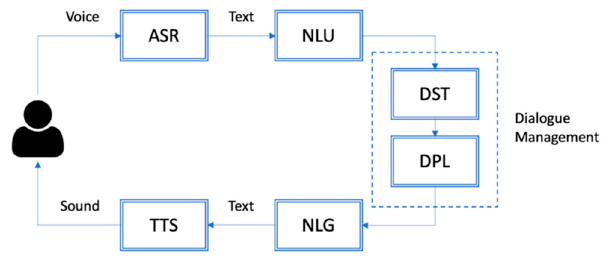
Figure 1. Modular architecture of task-oriented dialogue system.